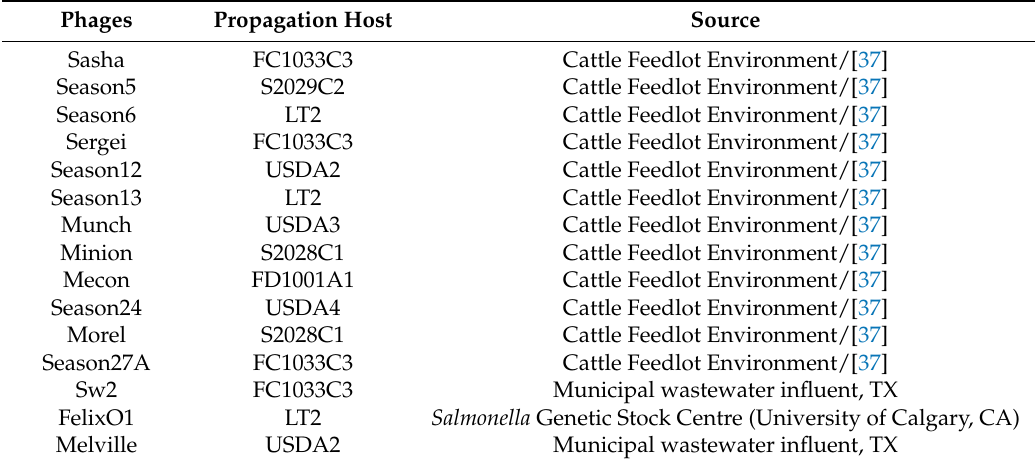
Table 2. Bacteriophages used in this study, their propagation hosts, and their